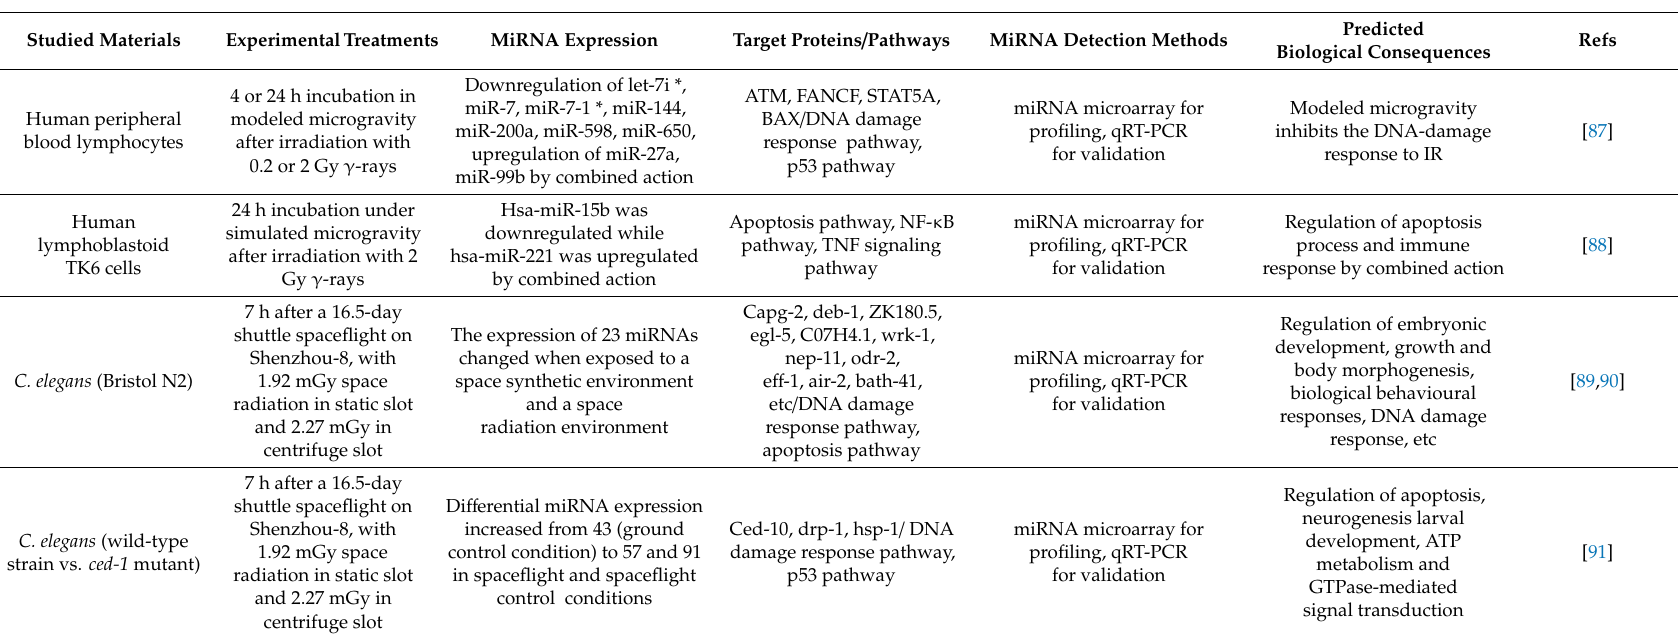
Table 2. Studies relating to miRNAs responding to space compound